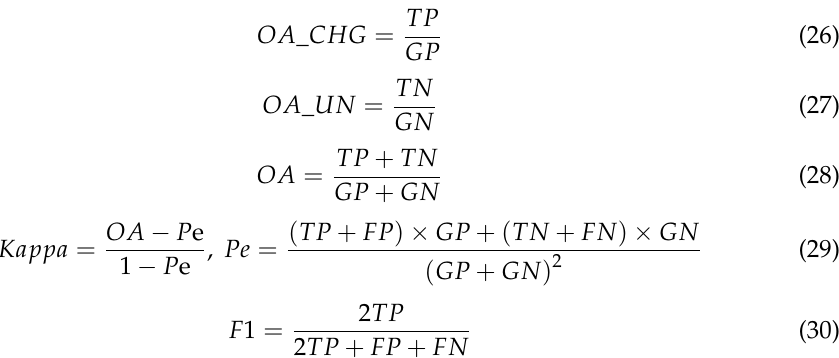
Figure 4. Tested datasets ‘River’ and ‘Taizhou’; ( a 1) and ( b 1): scene images of dataset ‘River’; ( c 1): the ground truth map of dataset ‘River’; ( a 2) and ( b 2): scene images of dataset ‘Taizhou’; ( c 2): the ground truth map of dataset ‘Taizhou’.